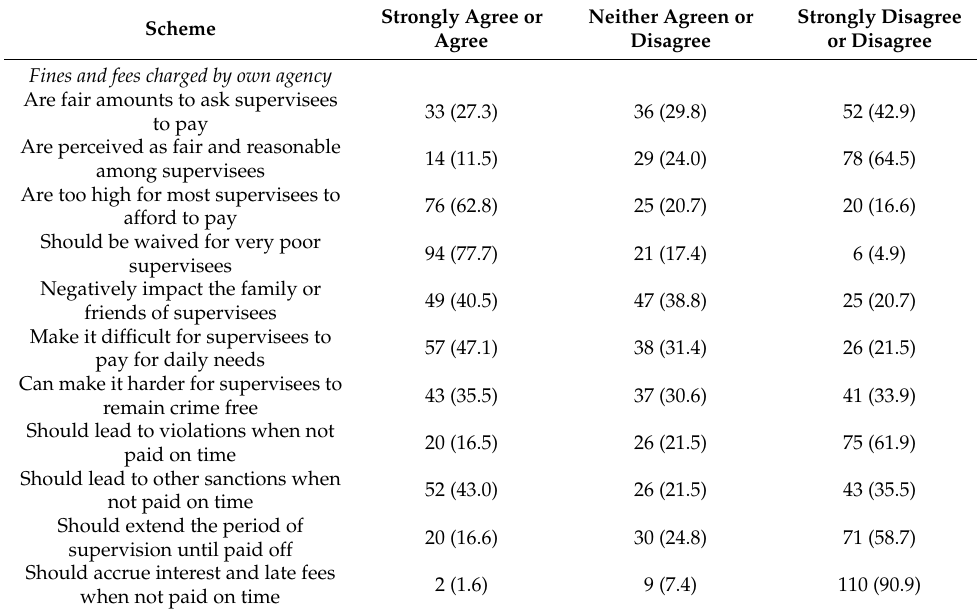
Table 2. Respondent Degree of Agreement with Statements Pertaining to Fines and Fees Policies (Percentage) (N =